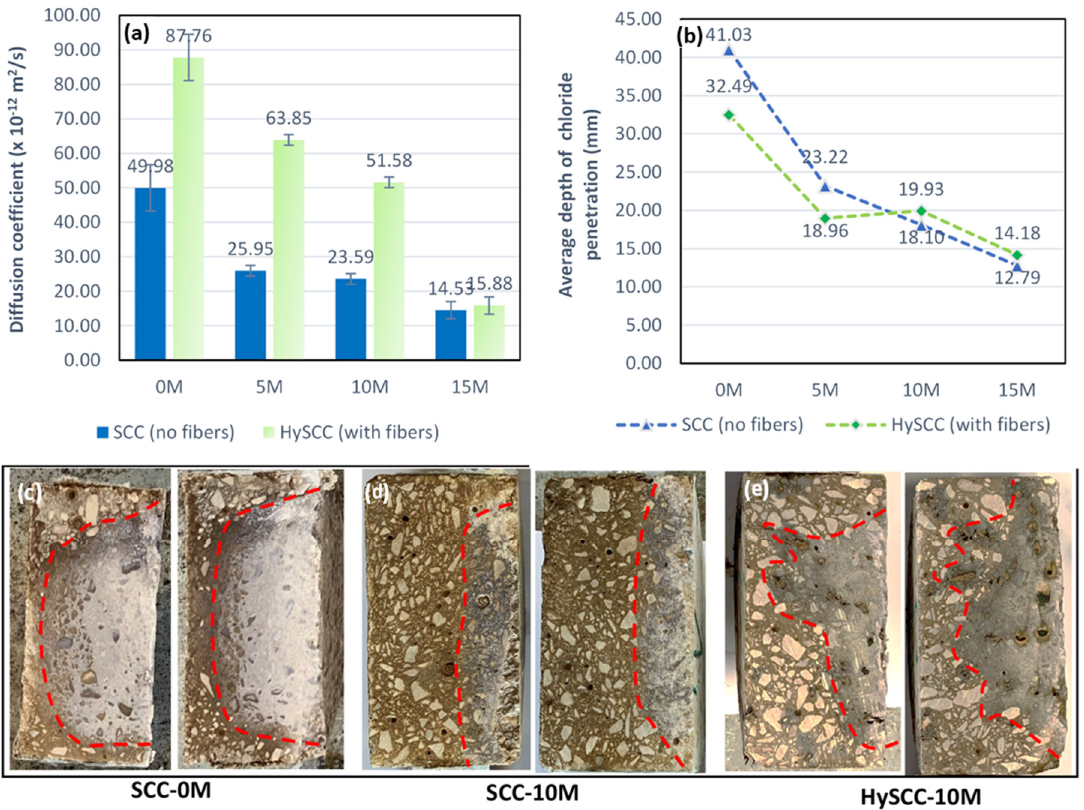
Figure 7. ( a ) Chloride migration coefficient from non-steady-state migration for SCC samples without fibers and HySCC samples containing fires, ( b ) the average depth of chloride migration in mm on tested specimens that were axially split into two pieces, formation of white AgCl product on ( c ) SCC-0M, ( d ) SCC-10M, and ( e ) HySCC-10M.